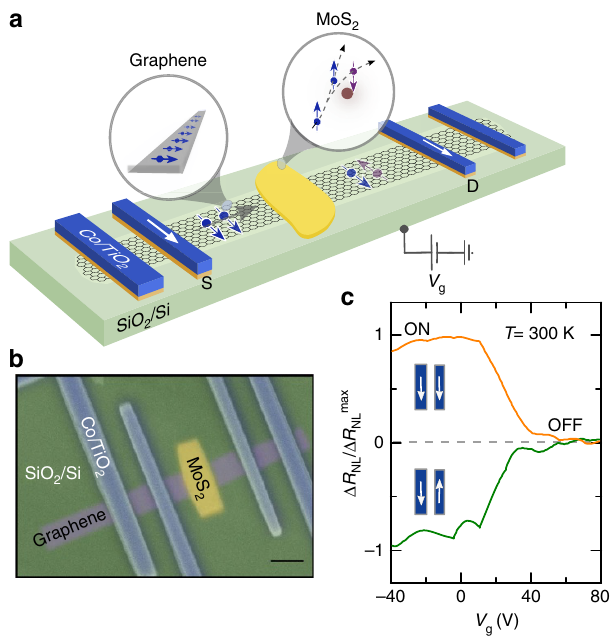
Figure 1 | MoS 2 /graphene vdWh. ( a ) Schematics of graphene/MoS 2 heterostructure channel with FM source (S) and drain (D) contacts. This structure allows spin injection into graphene from the source (S), diffusive spin transport in the graphene/MoS 2 channel, spin manipulation by a gate voltage and detection of spin signal by the drain (D). ( b ) Coloured scanning electron microscope image of a fabricated device with a CVD graphene/ MoS 2 heterostructure channel and multiple FM tunnel contacts of TiO 2 (1nm)/Co(80nm) (scale bar, 1 m m). The devices are fabricated on Si/SiO 2 substrate, which is used as a gate electrode for control of the spin polarization in the channel. ( c ) Gate dependence of the measured NL resistance D R NL ¼ D V NL = I ð Þ normalized to the maximum value, showing transistor-like ON/OFF spin signal modulation at room temperature, for parallel and antiparallel magnetization alignments of source and drain.